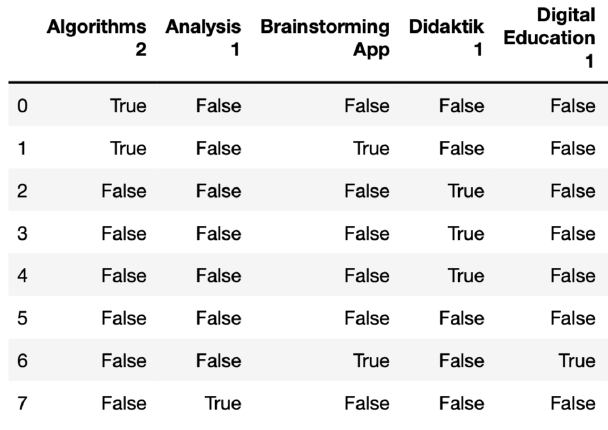
Figure 7. Snippet of the one-hot representation of the